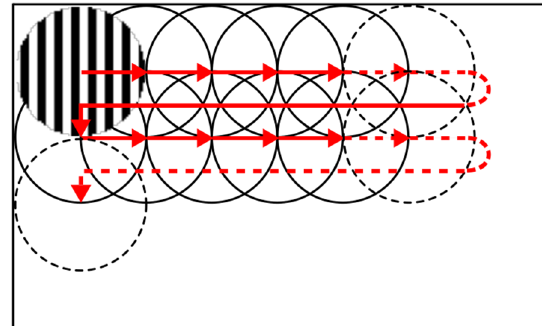
Fig. 6. Calibration of the DMD wavefront. Each pattern is composed of a round